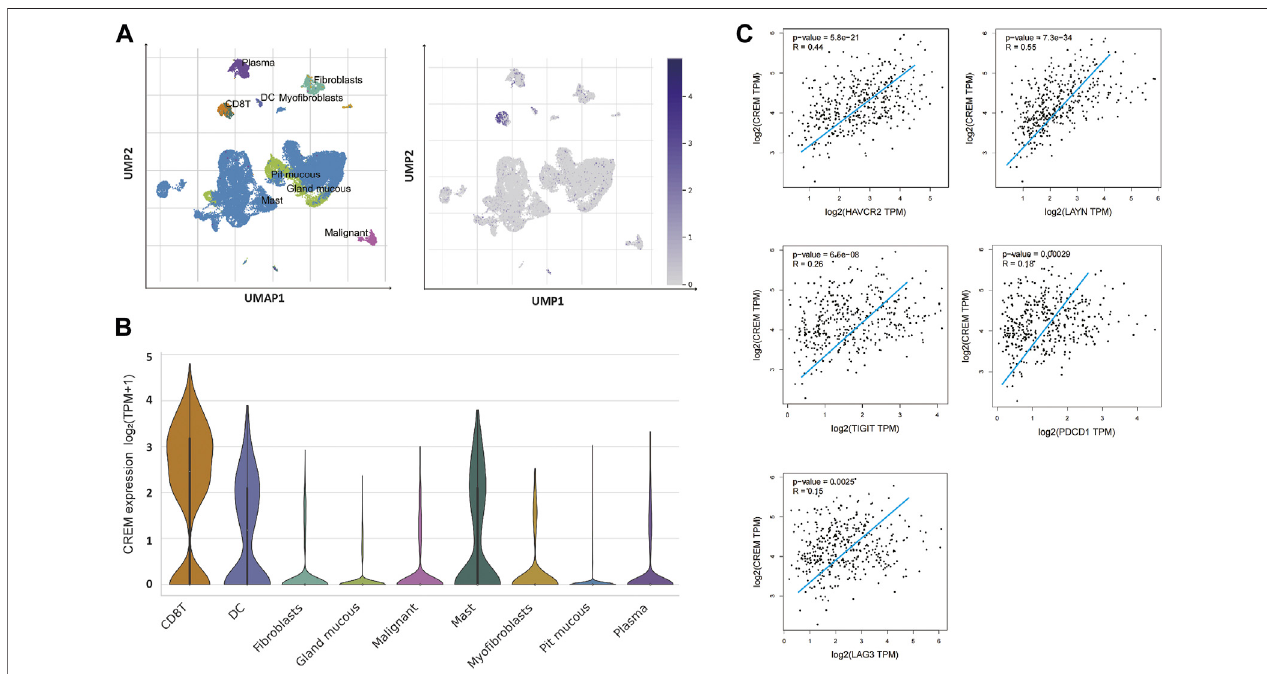
FIGURE 3 | The CREM expression analysis of tumor-in fi ltrating lymphocytes in GAC. (A) UMAP of GAC tumor tissue single-cell dataset, UMAP of GAC single cell dataset showed that high expression of CREM in CD8+ T cells. The depth of blue represents the amount of gene expression. (B) Violin plots showing the expression of CREM in various cell types. (C) Relationship between CREM expression level and T-cell exhausted marker genes expression level in the TCGA database (gene expression value is log2 TPM).